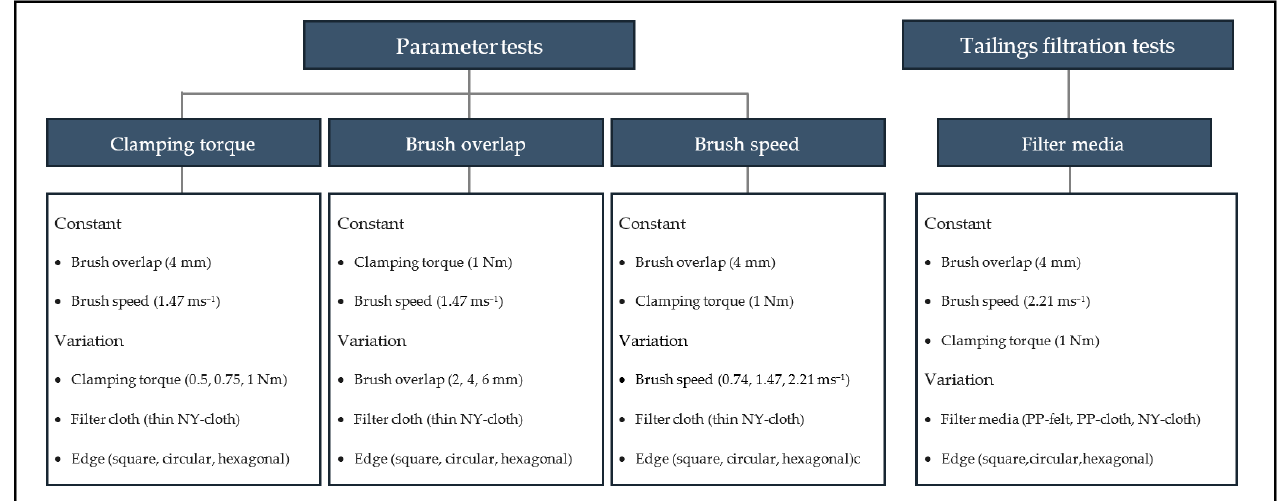
Figure 4. Overview of abrasion test for apparatus parameter evaluation and tailings filter media investigation.